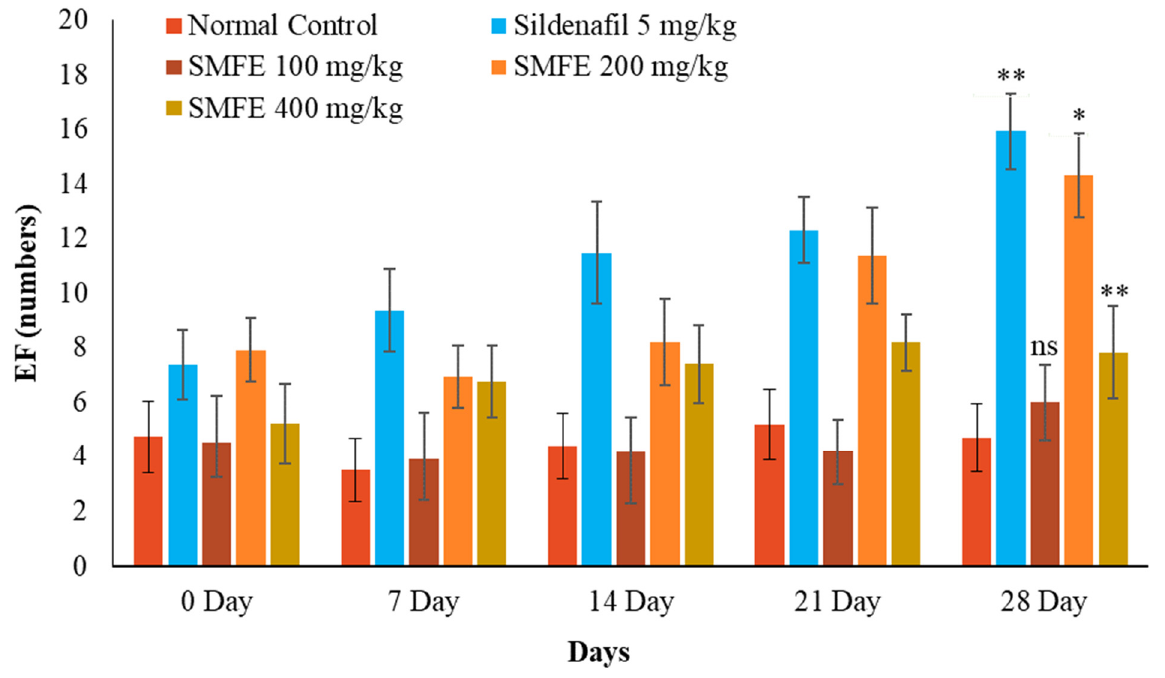
Figure 8. Effect of S. mangifera fruit extract on ejaculation frequency ( n = 6). The values are means ± SEM; * p < 0.05, ** p < 0.1; ns p > 0.05 (followed by Student Dunnett test).